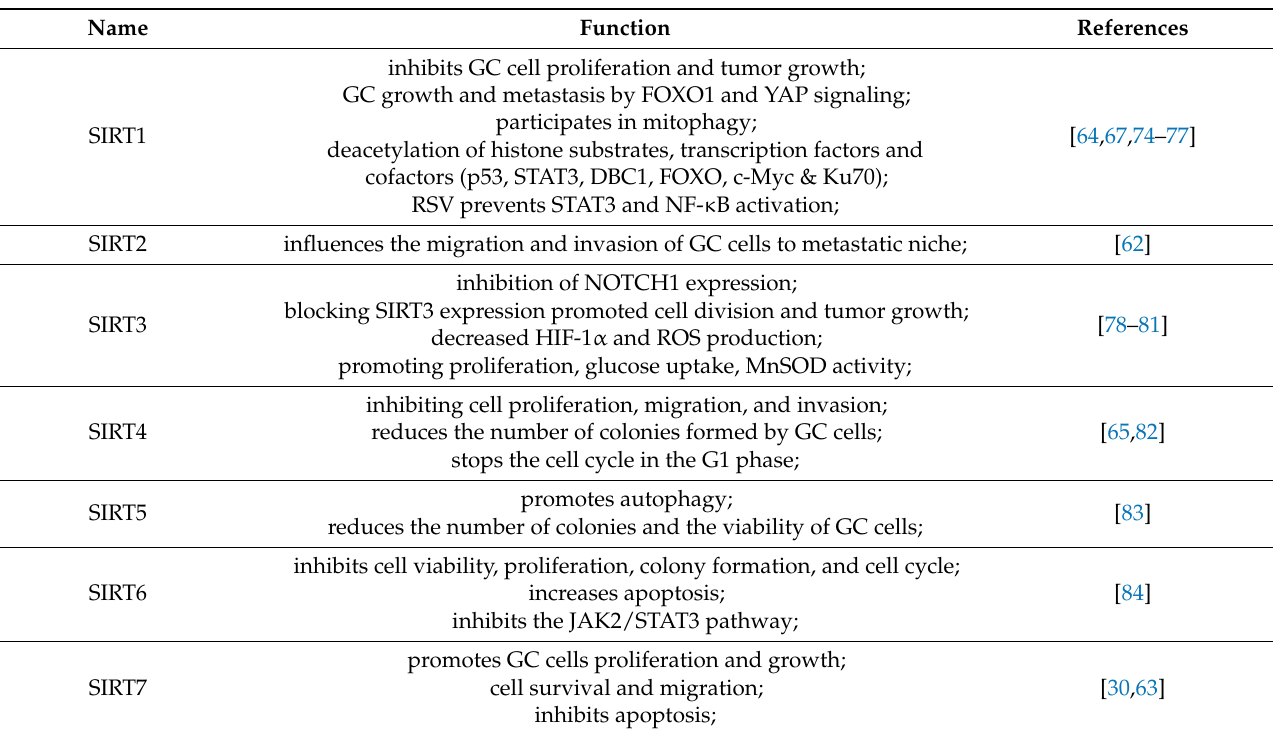
Table 1. The role of sirtuins in gastric